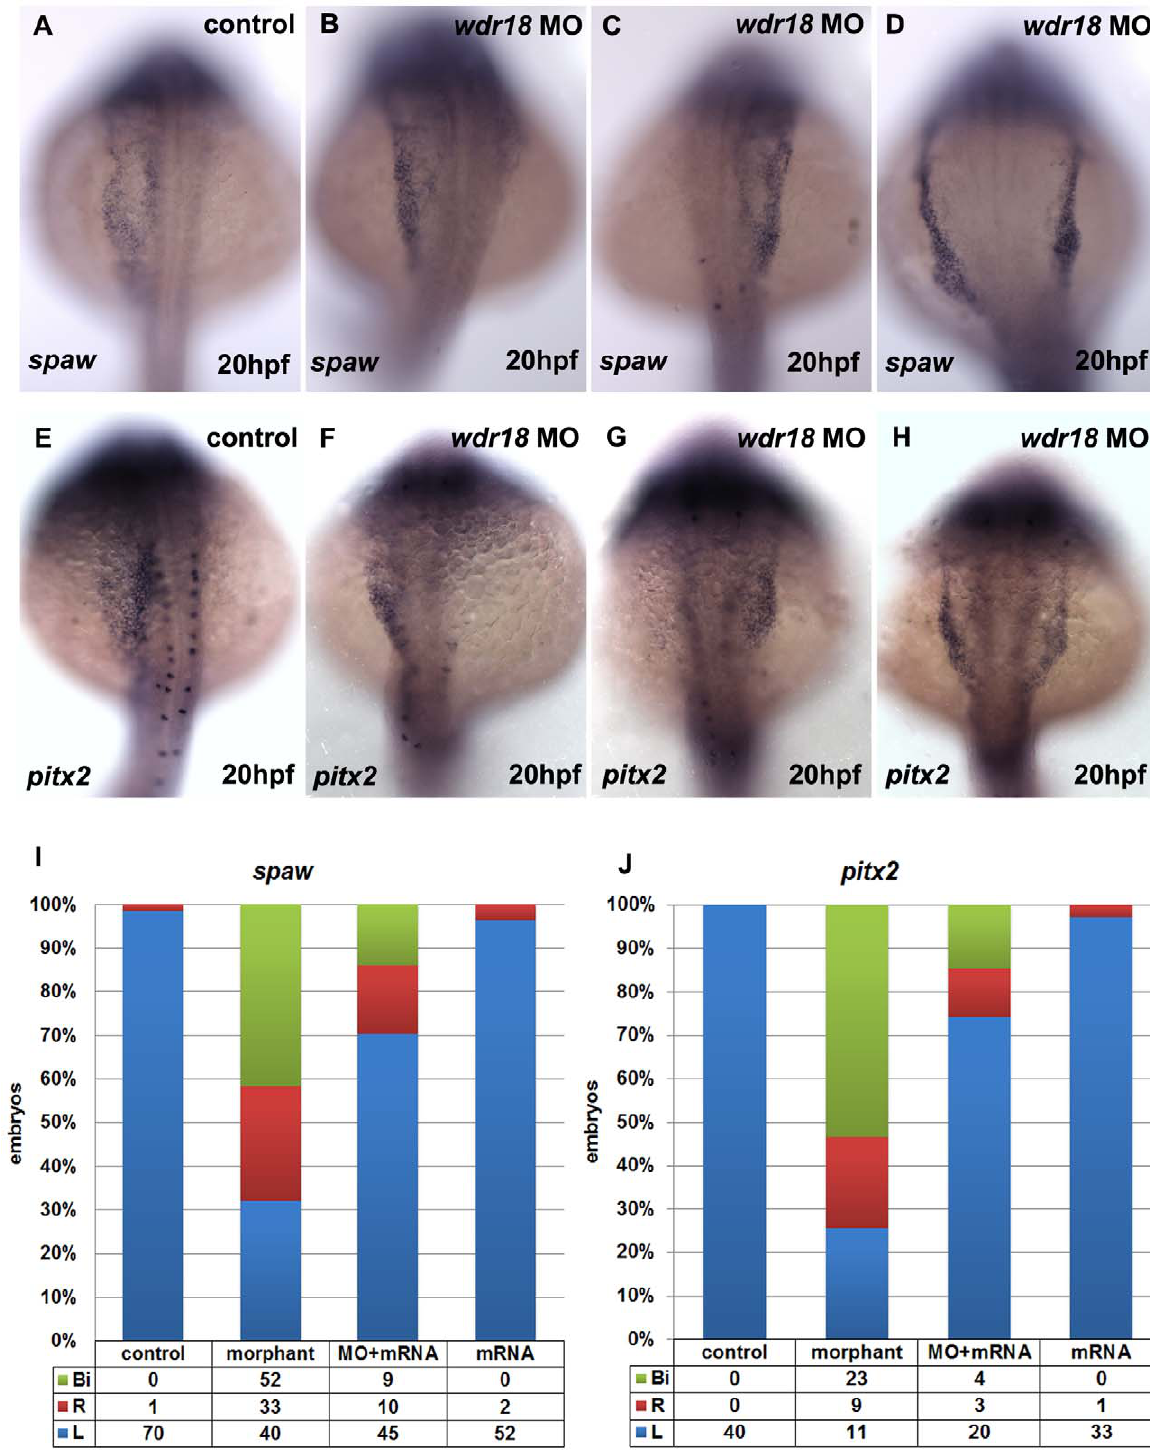
Figure 3. wdr18 morpholino caused randomized expression of spaw and pitx2 . In nearly all control embryos, spaw and pitx2 showed left- sided expression (A, E), whereas wdr18 morphants showed left-sided (B, F), right-sided (C, G), or bilateral (D, H) spaw or pitx2 expression in the LPM. (I, J) The percentage of control, morphant, mRNA-rescued and mRNA over-expressed embryos with left-sided (L), right-sided (R), or bilateral (Bi) spaw and pitx2 expression. (A–H) Dorsal views, anterior to the top.